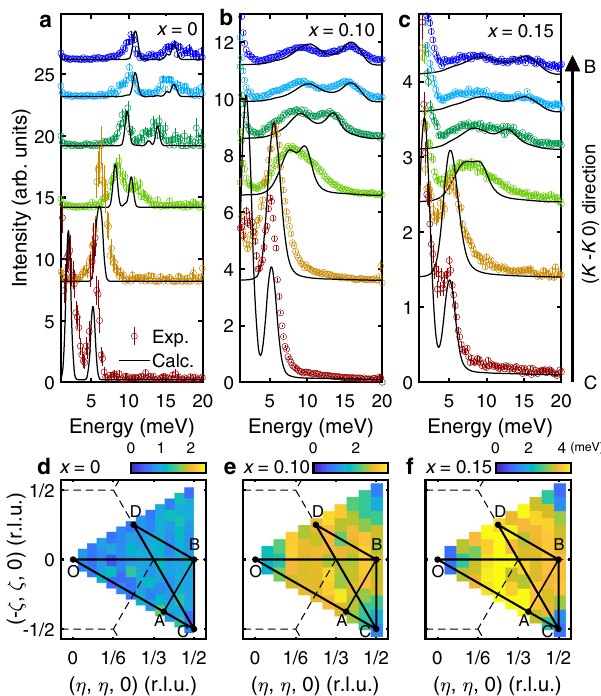
Fig. 3 Q- dependent magnon linewidth broadening due to doping. a – c Constant Q -cuts (colored circles) and theoretically calculated INS cross-sections (solid black lines) of a h -YMnO 3 , b h -YMn 0.9 Al 0.1 O 3 , and c h -YMn 0.85 Al 0.15 O 3 at various Q points along the [ K , - K , 0] direction (the C-B direction). Both the experimental data and the theoretical calculation results are rendered with the intensity integration along the c ∗ -axis. d – f Fitted intrinsic HWHM ( Γ ( Q )) of the magnon modes in d h -YMnO 3 , e h -YMn 0.9 Al 0.1 O 3 , and f h -YMn 0.85 Al 0.15 O 3 over the full Brillouin zone, where the instrumental resolution effects are excluded (see